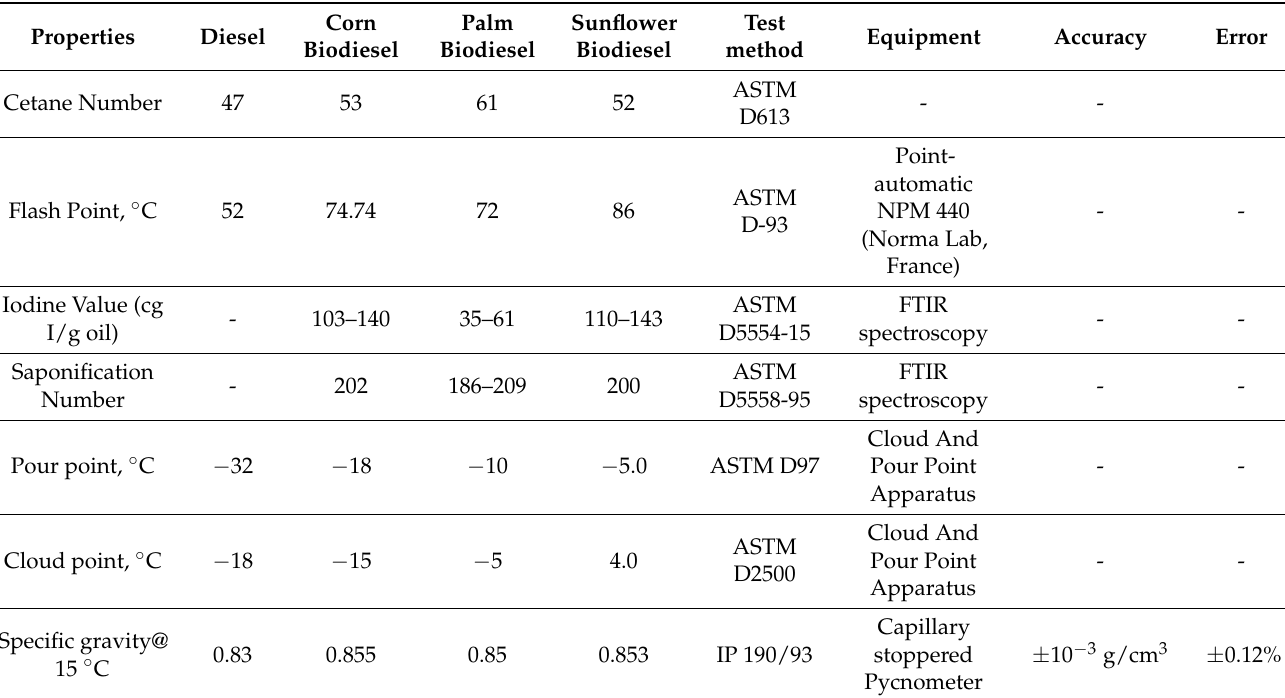
Table 4. Measured fuel blend properties of all tested fuel